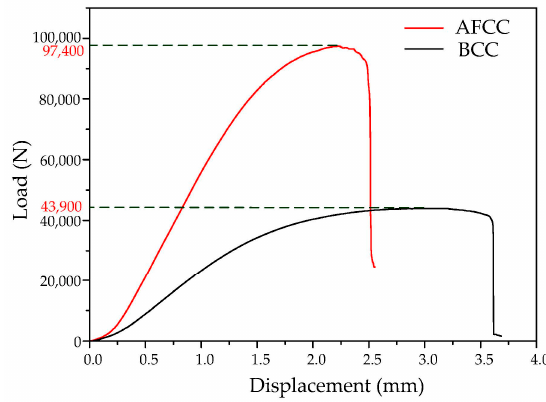
Figure 12. Experimental load–displacement curves of AFCC and BCC lattice structures.